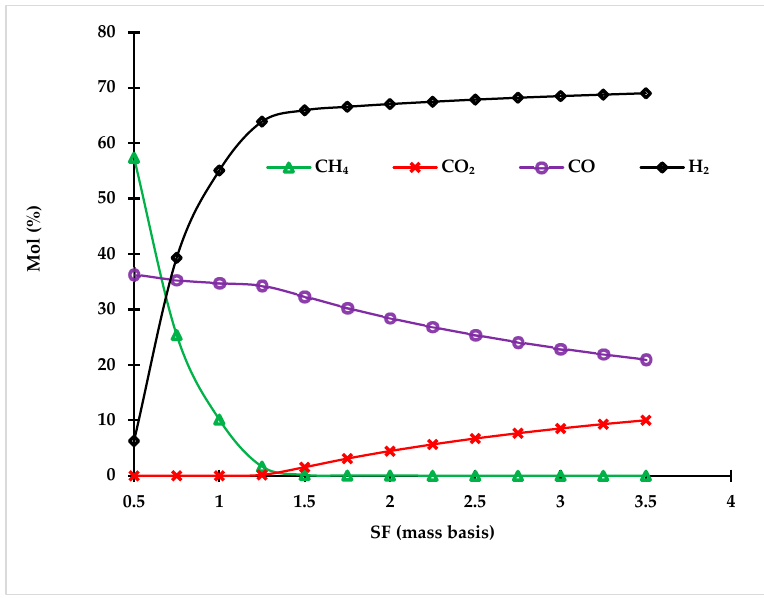
Figure 5. Effect of steam to plastic ratio on syngas composition.